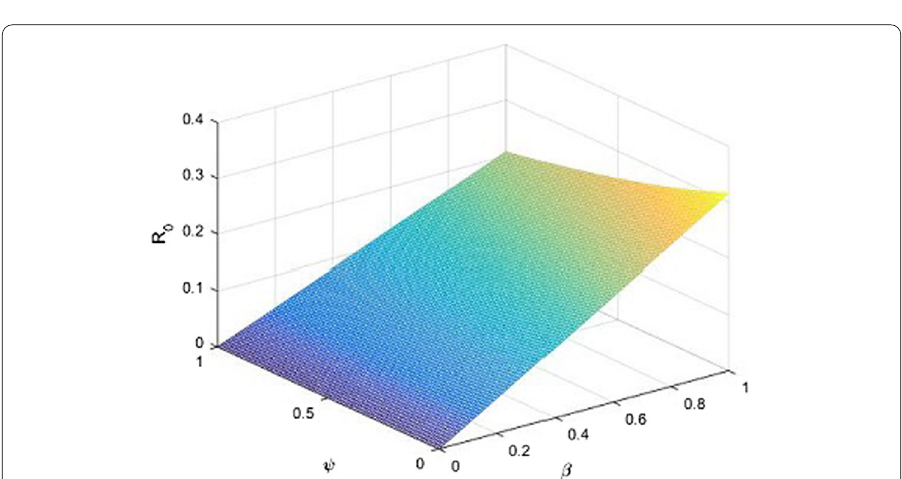
Figure 4 Numerical simulation of the reproductive number as functions of β and